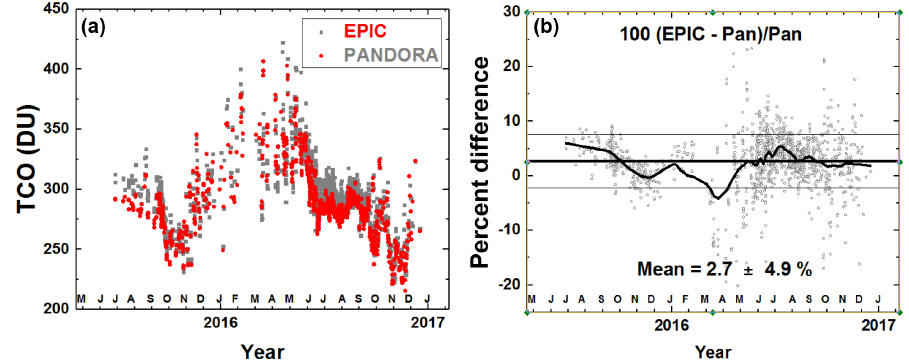
Figure 8. Daily O 3 data for EPIC (red) and Pandora (grey), 2015–2016. (a) EPIC ozone data compared to Pandora retrievals at Boulder, Colorado. (b) Percent difference between EPIC and Pandora.